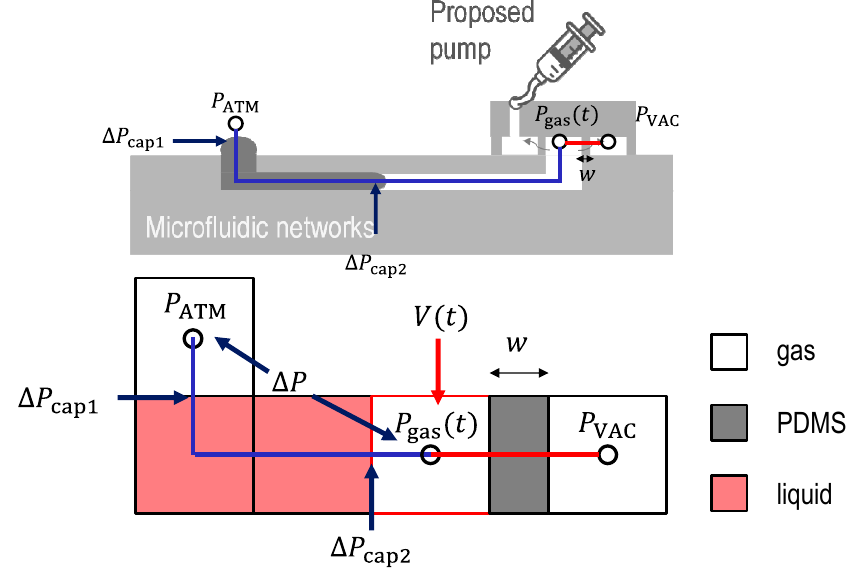
Figure 2. An equivalent model of the gas pressure inside channel. P ATM (Pa) is the atmospheric pressure, ∆ P cap1 ( Pa ) is the capillary pressure between gas-liquid at inlet, ∆ P ( Pa ) is the pressure di ff erence across the liquid column, ∆ P cap2 ( Pa ) is the capillary pressure between the gas-liquid in channel, ∆ P gas ( t ) ( Pa ) is the gas pressure inside channel, P VAC ( Pa ) is the gas pressure inside the vacuum chamber, V ( t ) ( m 3 ) is the gas volume inside channel, ∆ N A is the di ff usion rate of gas molecule, w ( m ) is the thickness of PDMS wall, and p ( Barrer ) is the permeability coe ffi cient of PDMS. Here, 1 Barrer = 3.35 × 10 (cid:2879)(cid:2869)(cid:2874) mol · m (cid:2879)(cid:2869)· s (cid:2879)(cid:2869) · Pa (cid:2879)(cid:2869) .